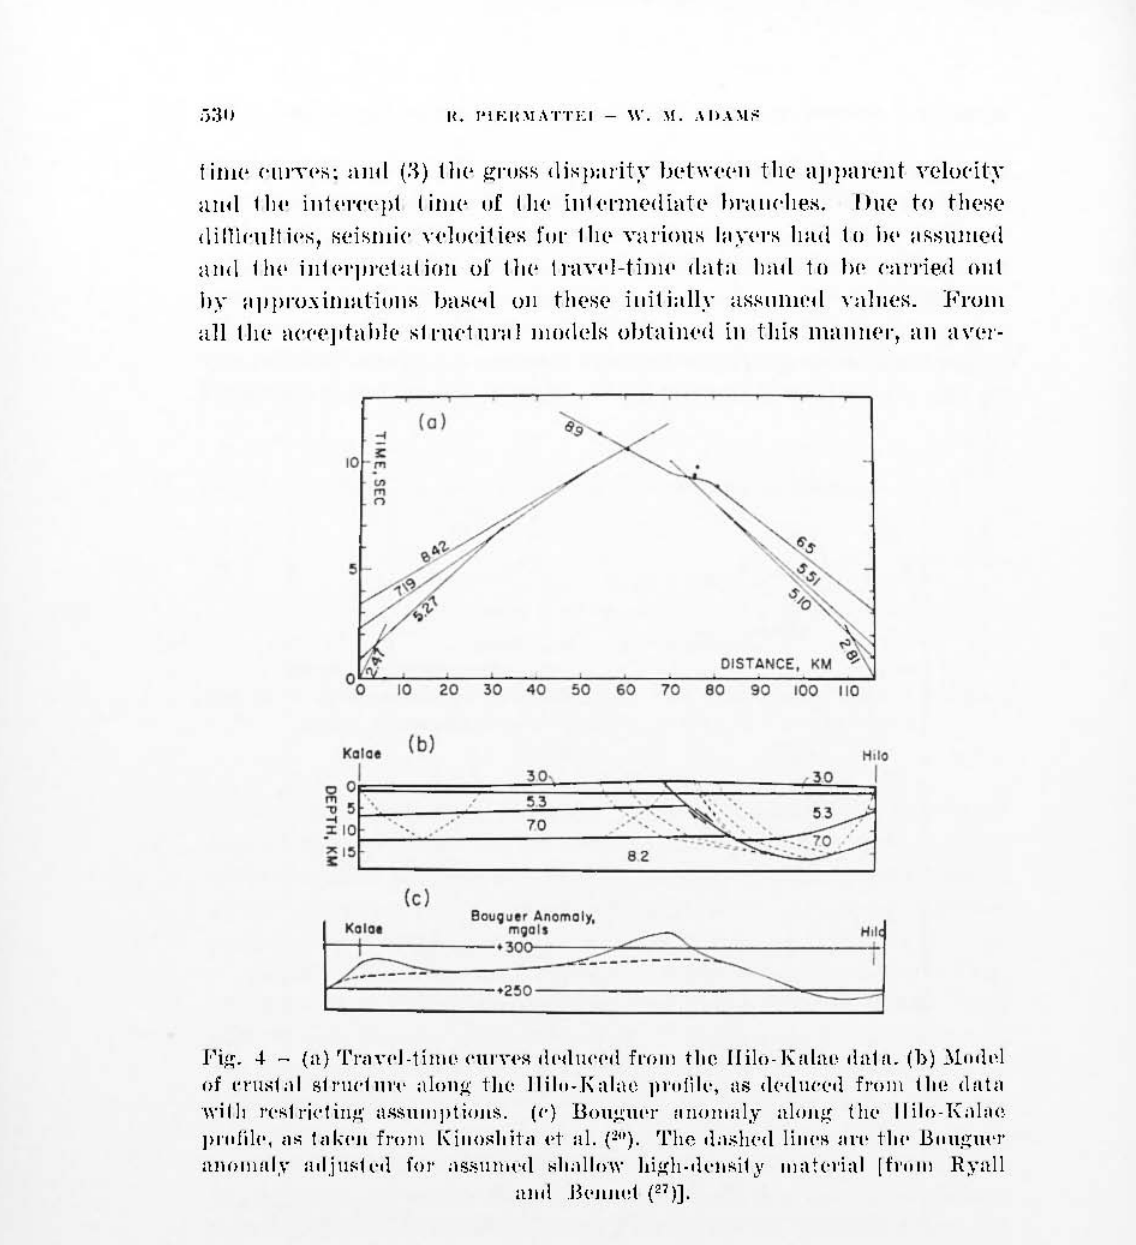
Fig; . ..f- - {a} 'l'rnY('J-tillll' l'\UYP~ d('(IU('pd frolli tlle llilo-Kalm' Ilata. (h) .:Ilo,jP) of l'ruHlal sI J'\U'1UI'I' aloug lhe llilo·I\alae ]il'o1ile, as '\(o']Ul'(',j frOlli lll(~ data \\"illi J'('klri\'lillg' a.~slllllptioIlS. (l') llollglll'r illlOlllal,Y aloll!-( (hl' Ililo-Kalill' pl'ldilp, nH lnkpll frOJII Killo~lliln 1'1 al. e'l. 'l'he ,ja.',jj(',]liIlPH lln' 111(' 13oll.glll'r alloJllal,\" ad.iu~Il',j for assuIIOI"] Hllallo\\" hig-h.,jl'lIkily IIlarl'l'ial [frolli